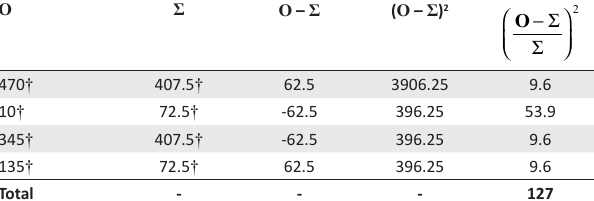
TABLE 7: Computation of Chi-square table.